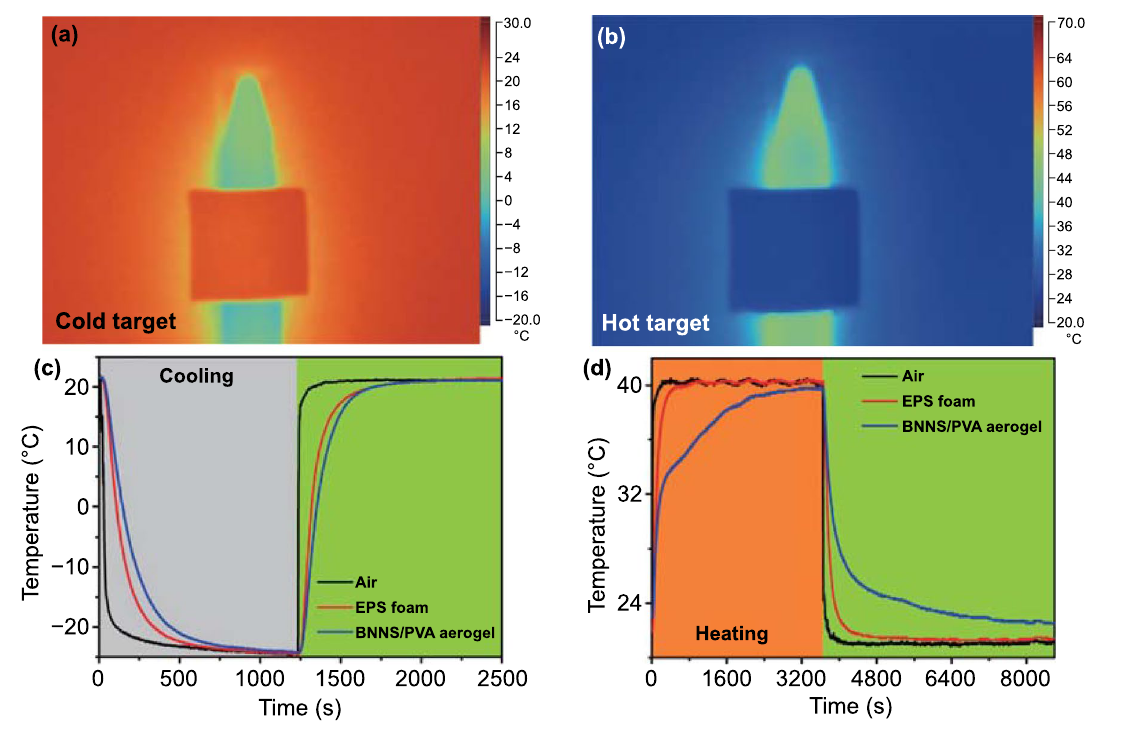
Fig. 4 Superinsulating BNNS/PVA composite aerogels for infrared stealth and temperature preservation. Infrared images showing stealthy per‑ formance of the BNNS/PVA composite aerogel on a cold and b hot targets. Temperature evolution of the BNNS/PVA composite aerogel, EPS foam and air when exposed to c cold (fridge) and d hot (oven)